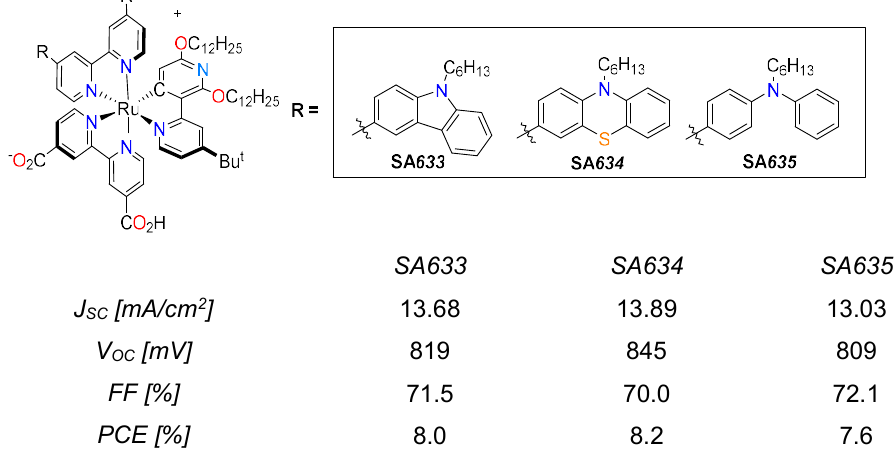
Figure 20 . Dye-loading values obtained from the desorption of dyes from sensitized titania films [114].